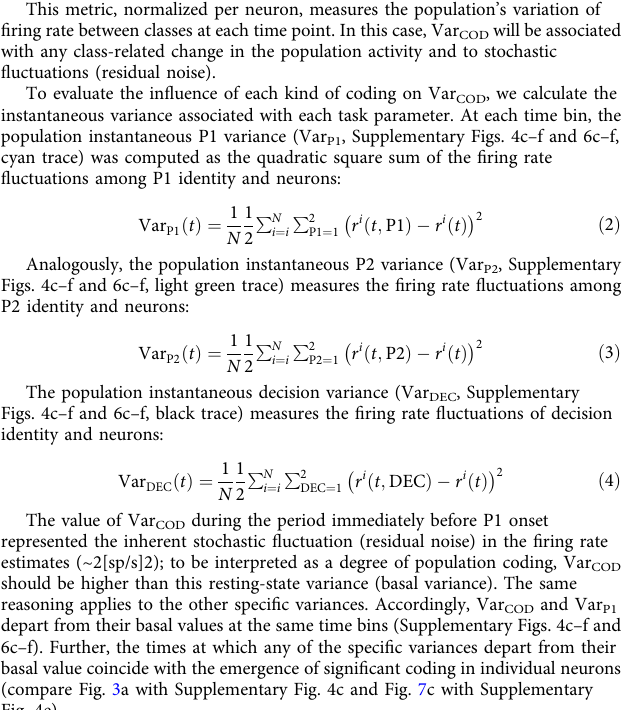
population information for each window. We showed that a 200ms window is optimal for decoding pattern identity from sensory neurons in areas 3b and 1 and S2 (Supplementary Fig. 10a – d). Categorical and DPC neurons reach a stationary value at this window-width (Supplementary Fig. 10g, h). Periodicity information . The extended patterns (E) are periodic with a frequency between pulses of 4.34 Hz (pf). Contrary to that, grouped patterns (G) are aperiodic (Fig. 1a, up pattern). Based on the temporal stimulus structure, a phase-locked neuron (sensory) should respond periodically during an extended pattern (E) at 4.34 Hz but not during grouped patterns (G). We aimed to compute the mutual information associated with the pattern identity (G or E) that is conveyed by